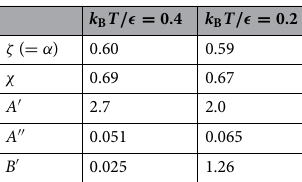
p 3 √ 2 / 8 0.530. Eqs. (9)–(12). 0.9 . ¯ = ≈ = −